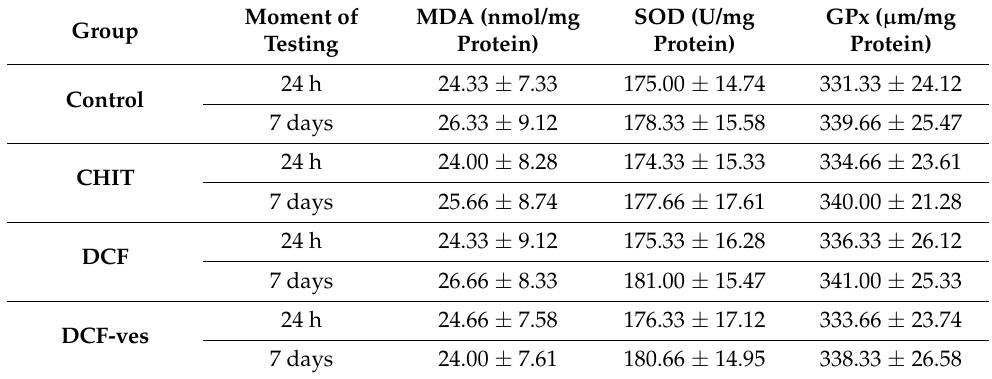
Table 8. Serum levels of MDA, SOD and GPx in animals treated with CHIT, DCF and DCF-ves. Values are expressed as the arithmetic mean ± S.D. of the average values for 6 animals per group.